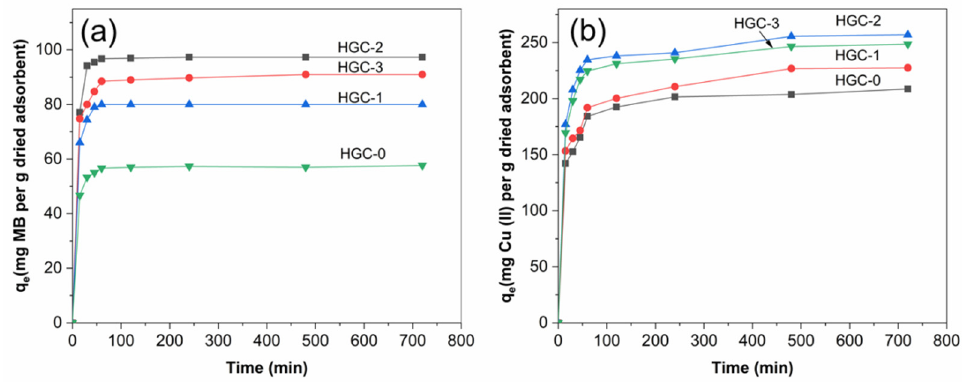
Figure 4. Effect of contact time on sorption capacities of the various HGC beads with ( a ) MB and ( b ) Cu (II) ions. Experimental conditions: 50 mg L − 1 initial MB concentration at pH 8.0, 500 mg L − 1 initial Cu (II) concentration at pH 5.0, and 100 mg dried beads under room temperature.